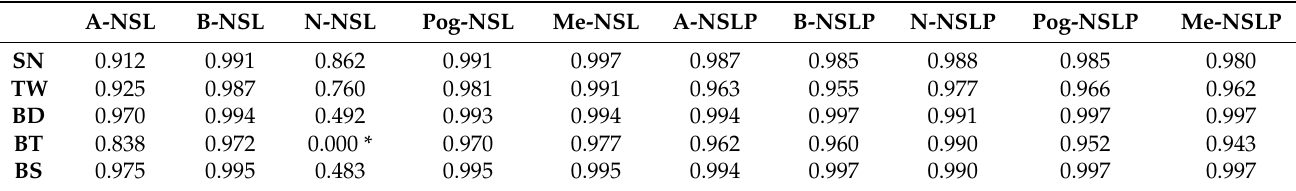
Table 5. Inter-observer reliability levels of all the studied superimposition methods (SN, TW, BD, BT, and BS), assessed as the ICCs for 10